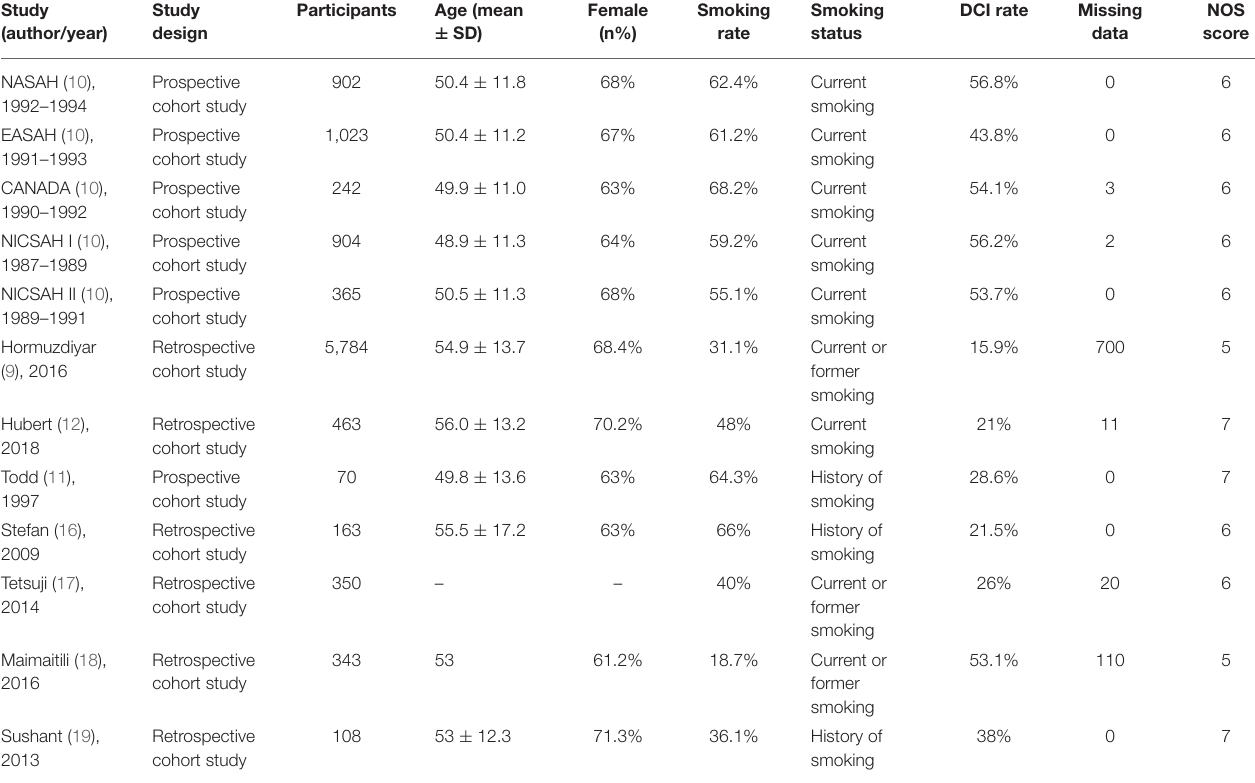
TABLE 1 | The characteristics of included studies for the present